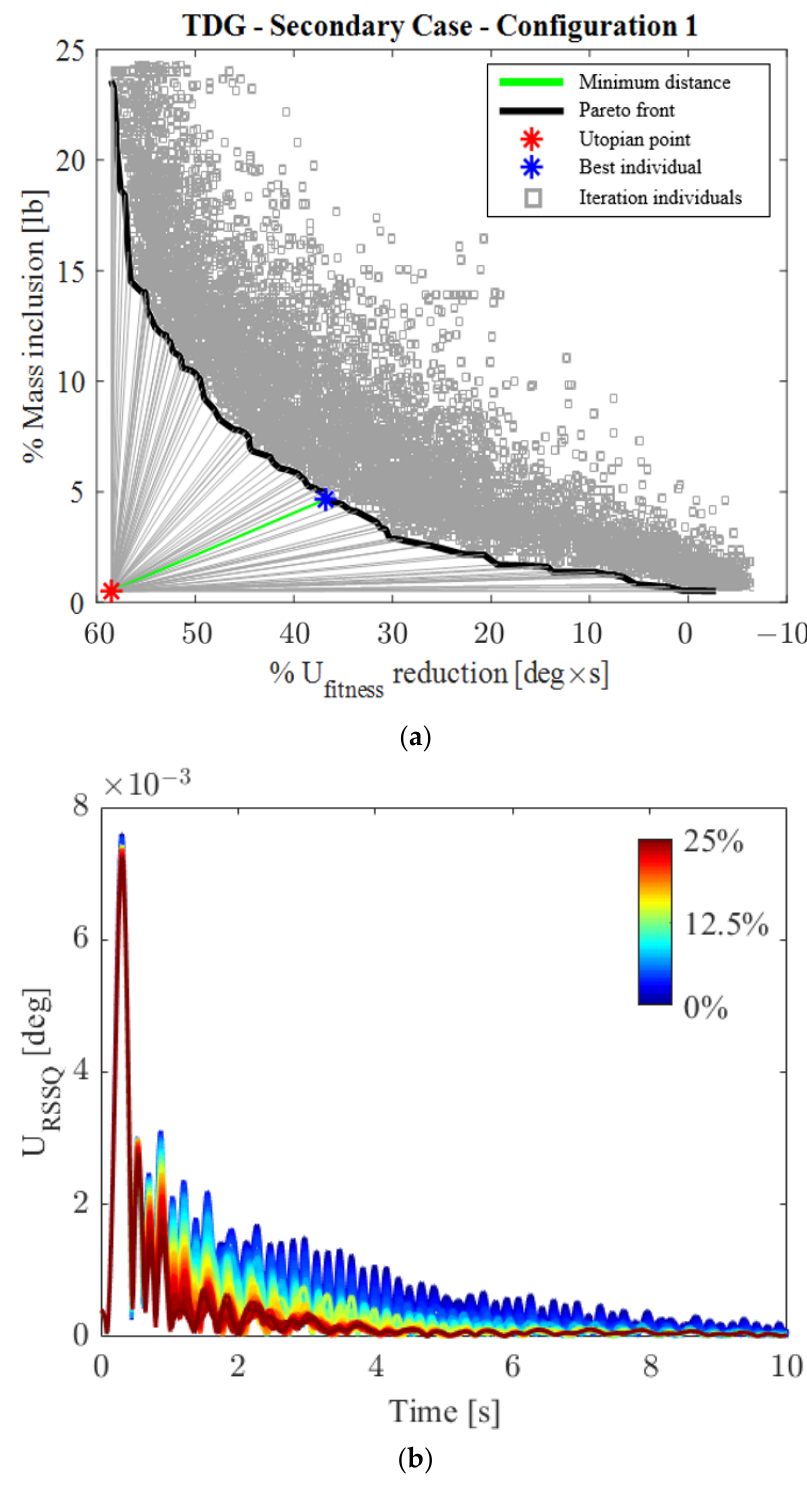
Figure 12. Pointing error minimization using the MTMD under configuration 1 for the secondary operational case modelled with the TDG. ( a ) Multi-objective Pareto front of all individuals analyzed, indicating the utopian point and the best individual. ( b ) Time response functions of the RSSQ deviation angle for each respective direction, where the color bar indicated represents the percentage of mass inclusion in the antenna.